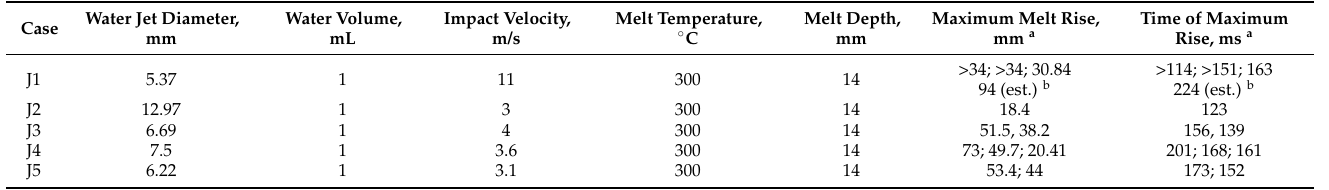
Table 3. Parameters of impulse-jet impact